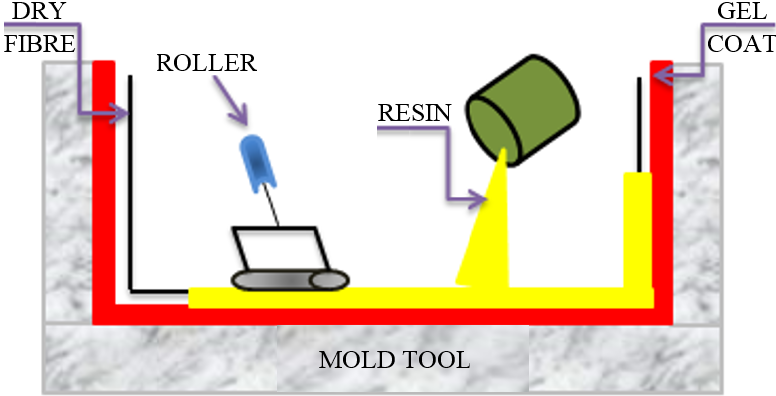
Figure 10. Illustration of the hand lay ‐ up manufacturing process sequences.